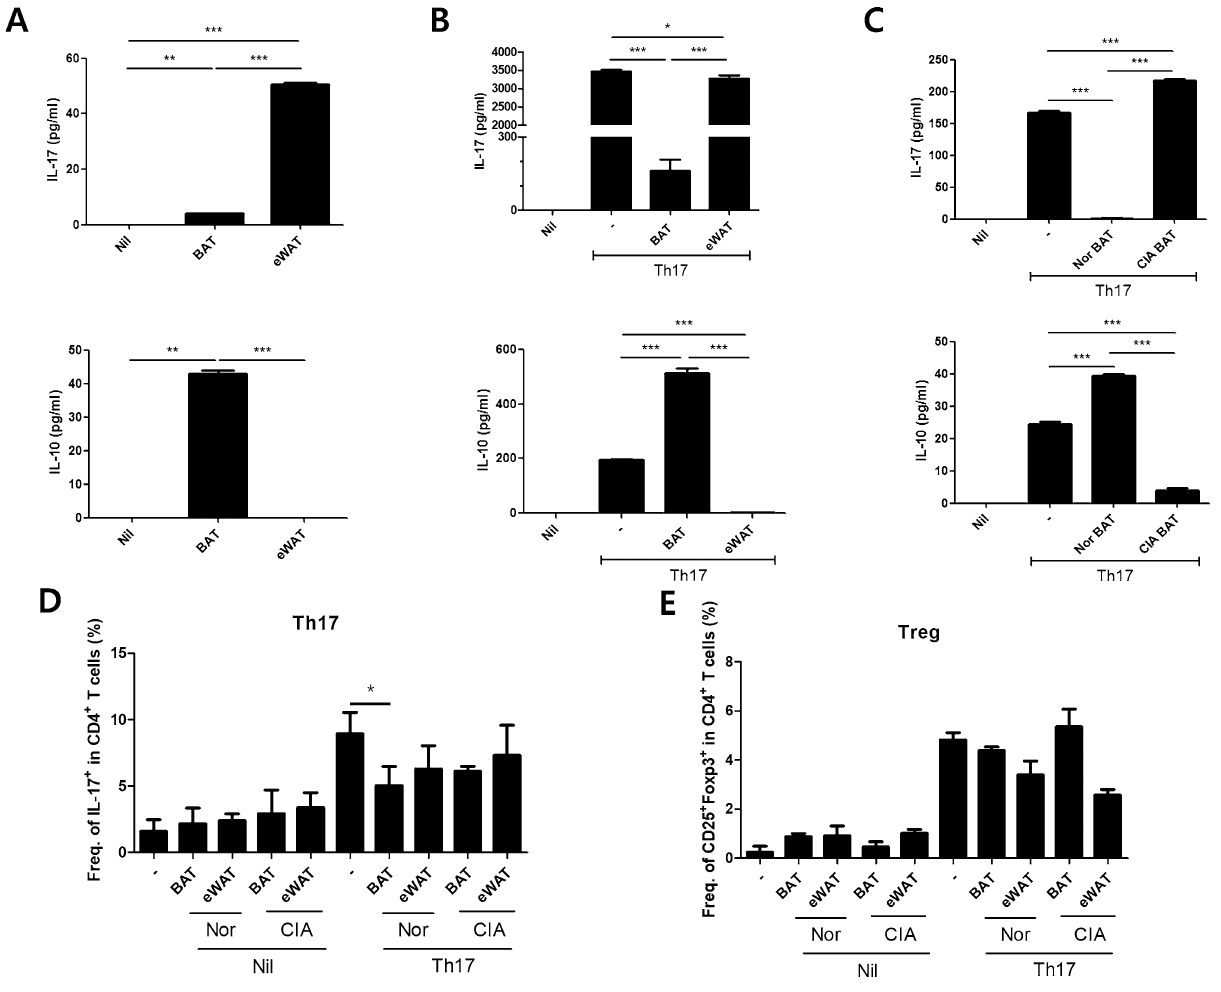
Figure 4. BAT inhibits Th17 differentiation and induces IL-10 expression in vitro. ( A ) IL-17 and IL-10 levels were measured by ELISA in BAT and eWAT. ( B ) Levels of IL-17 and IL-10 in BAT and eWAT were detected by ELISA under Th17-inducing conditions for 72 h. ( C ) IL-17 and IL-10 levels of normal BAT and CIA BAT were measured by ELISA. ( D , E ) The population of Th17 cells and Treg cells in BAT co-culture condition were measured. *P < 0.05, **P < 0.01, and ***P <